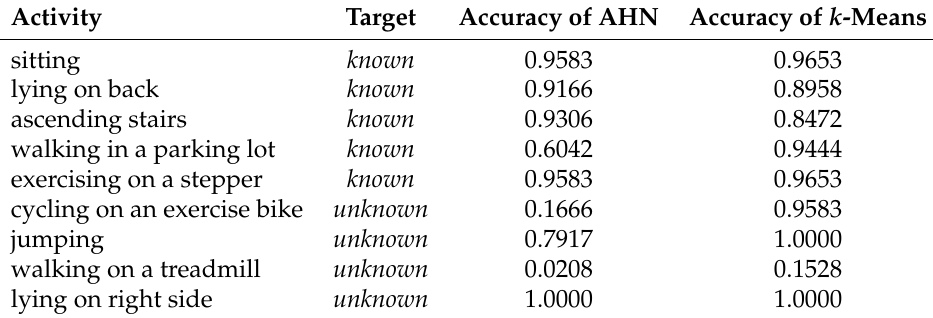
Table 4. Accuracy of the unknown-activity detection